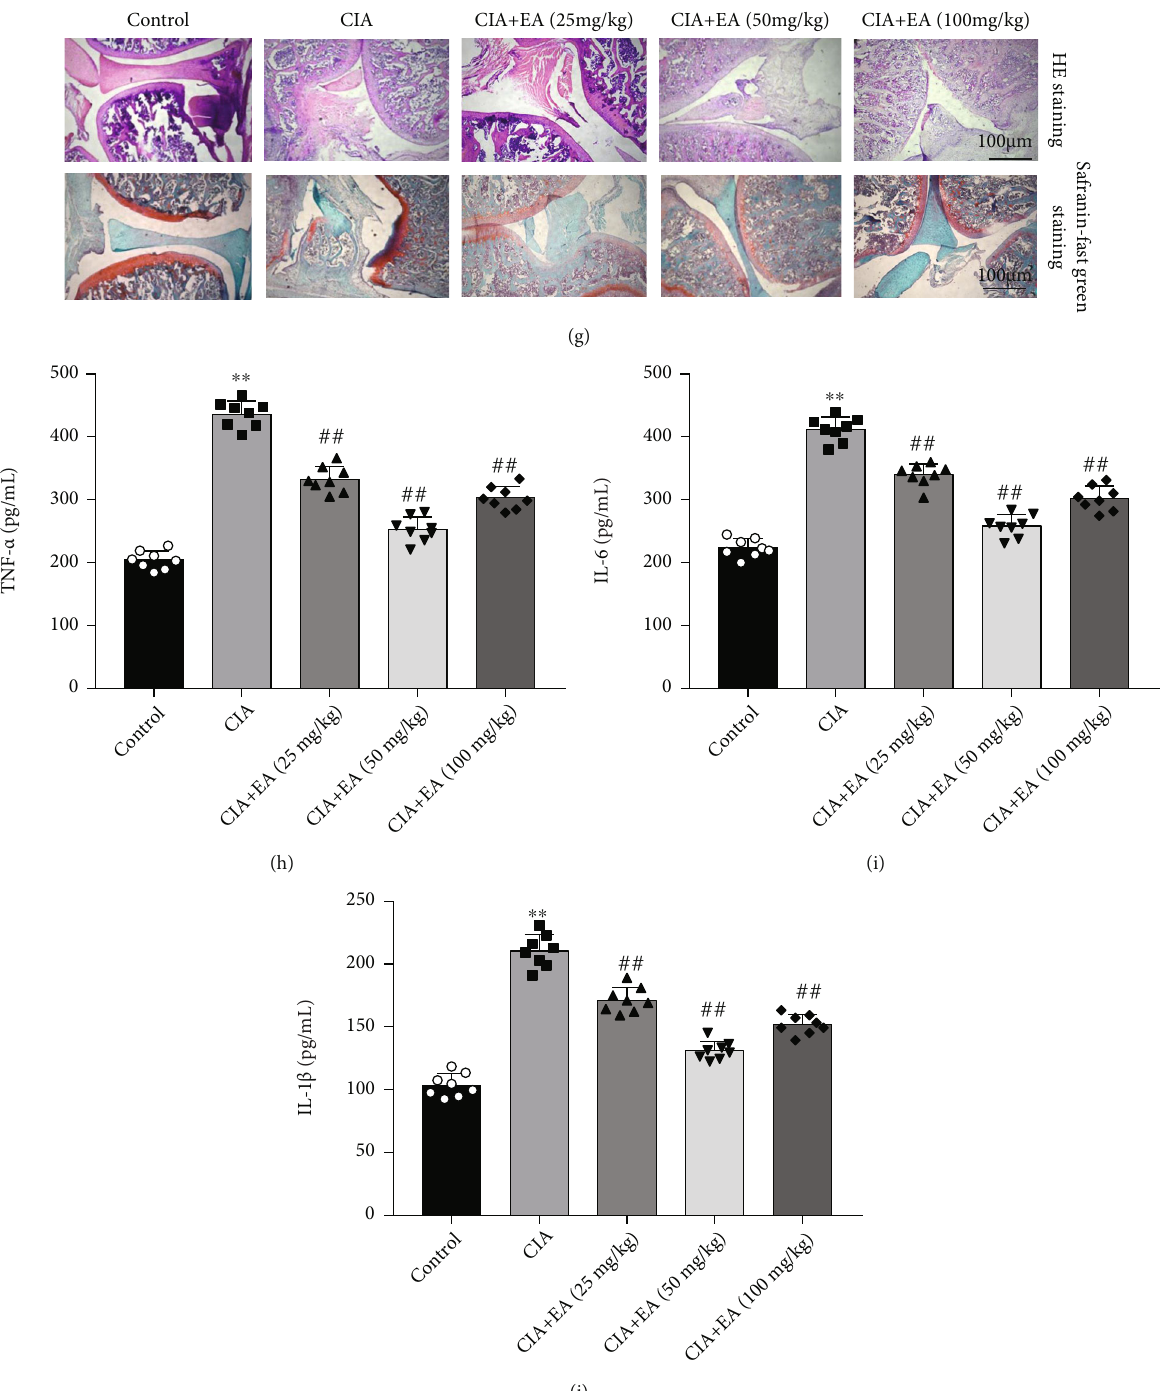
Figure 7: EA alleviated RA progression in CIA rats. Wistar rats were randomly divided into fi ve groups ( n = 8 per group): control, CIA, CIA+ EA (25 mg/kg), CIA +EA (50 mg/kg), and CIA +EA (100mg/kg). The rats were immunized by intradermally injecting the collagen emulsion to establish CIA rat model, and EA was orally administered. (a – d) The expression of MTA1, HDAC1, and Nur77 in synovial tissues of rats was measured by using Western blot analysis. (e) The arthritis index of rats in each group was detected once a week. (f) The paw swelling of rats in each group was detected once a week. (g) E ff ects of EA on histopathological changes in the synovial tissues of CIA rats, using HE staining. (h – j) The levels of TNF- α , IL-1 β , and IL-6 in synovial tissues were examined by using ELISA. Data from at least three replicate experiments were presented as mean ± SD . ∗∗ P < 0 : 01 compared with the control group; # P < 0 : 05 and ## P < 0 : 01 , compared with the CIA